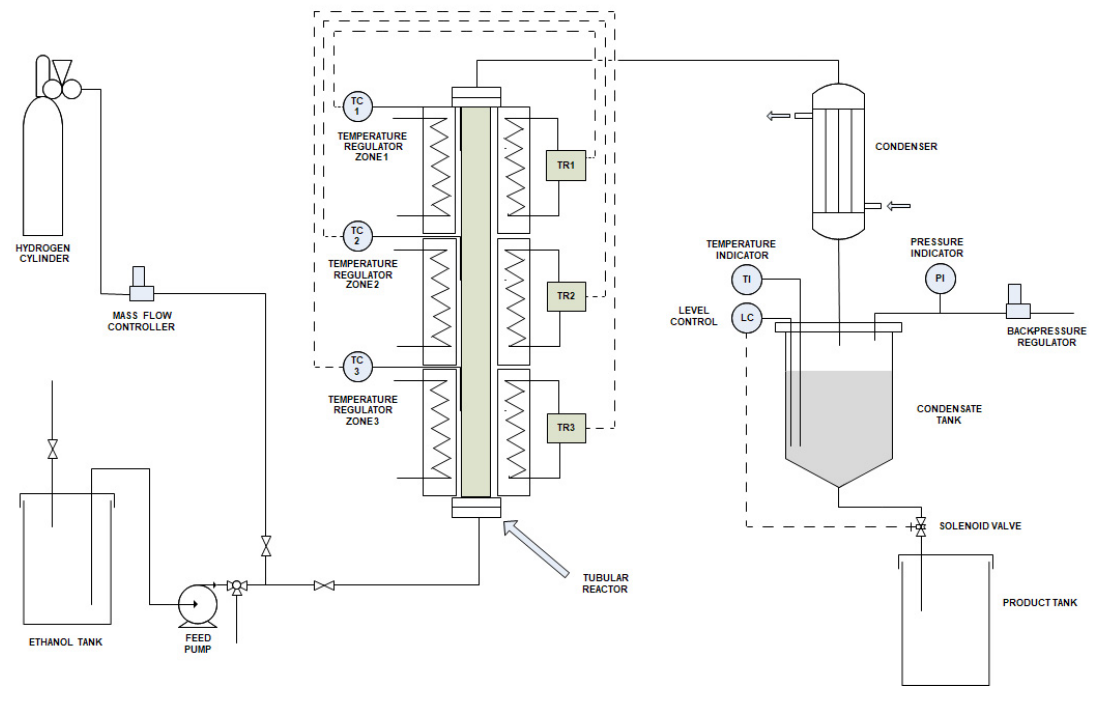
Figure 4. An example of the pilot plant suggested by the authors.